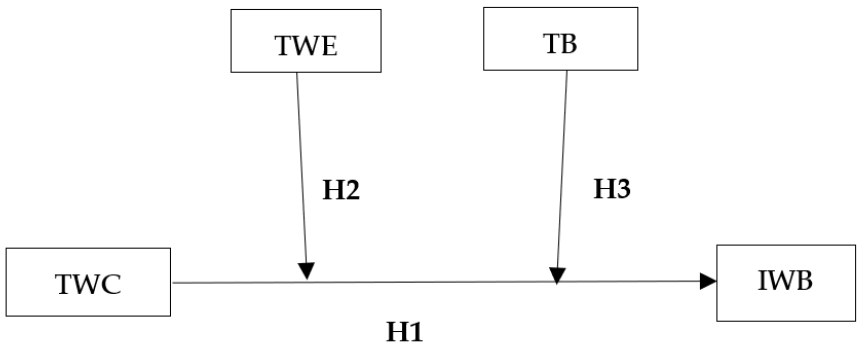
Figure 1. Conceptual model and proposed hypotheses.